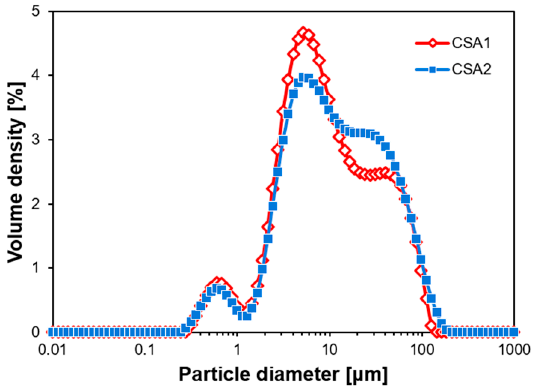
Figure 1. Particle size distributions of calcium sulfoaluminate (CSA) cements utilized. Table 1. Chemical and mineralogical compositions of CSA